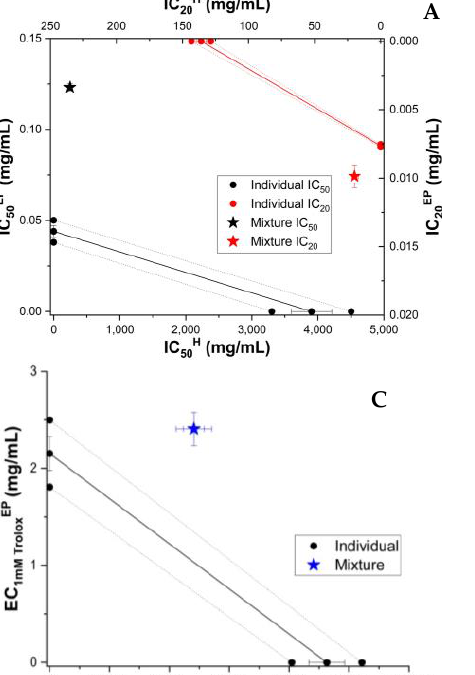
Figure 2. Isobolograms of honey (H) and caffeic acid (CA) based on IC 50 (half-maximal inhibitory concentration) and IC 20 (inhibitory concentration at 20% substrate inhibition) for DPPH ( A ) and ABTS ( B ) methods, and based on EC 1mM Trolox (effective concentration at 1 mM Trolox equivalent of the samples) for CUPRAC ( C ) and FRAP ( D ) methods. The error bars from three measurements are shown for each value. Confidence intervals at 95% confidence are shown by dashed lines.